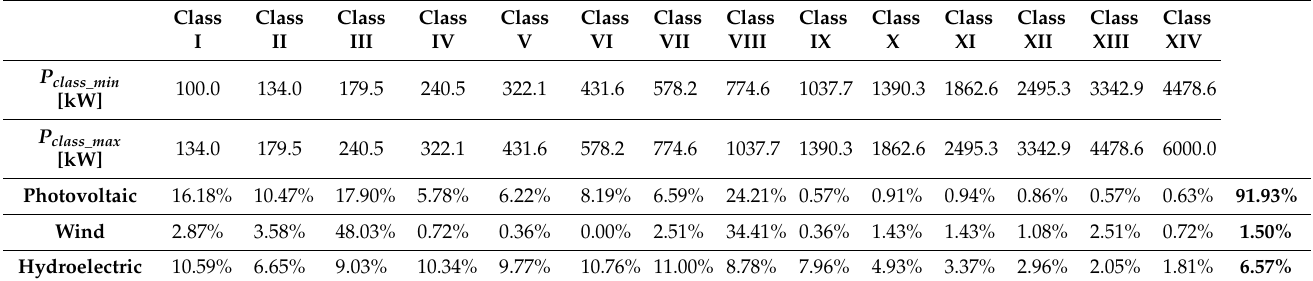
Table 1. Distribution of technology ( w tech ) and power ( w power ) classes.